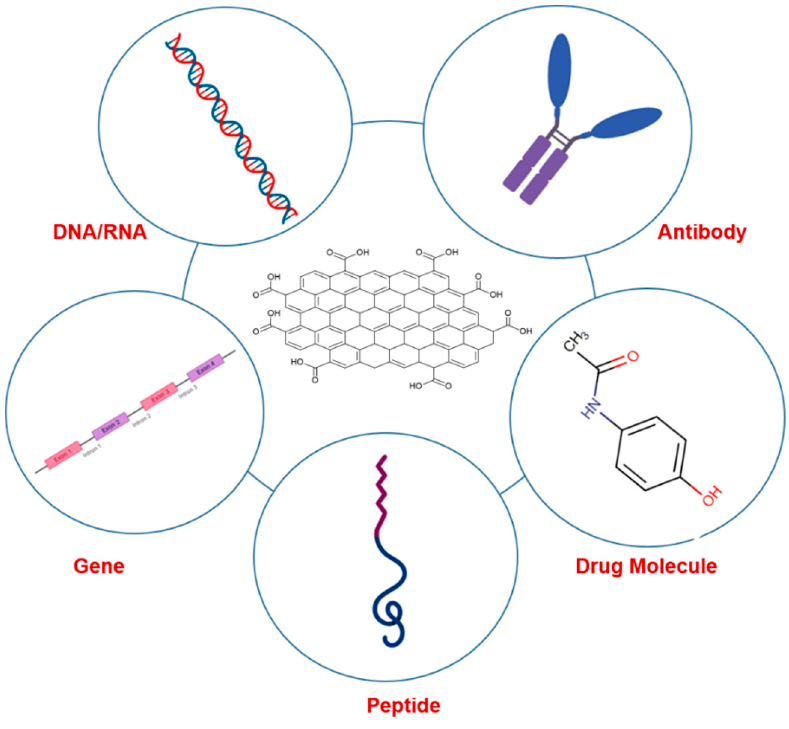
Figure 2. Illustration of common modifications of graphene oxide (GO) as a nanocarrier.